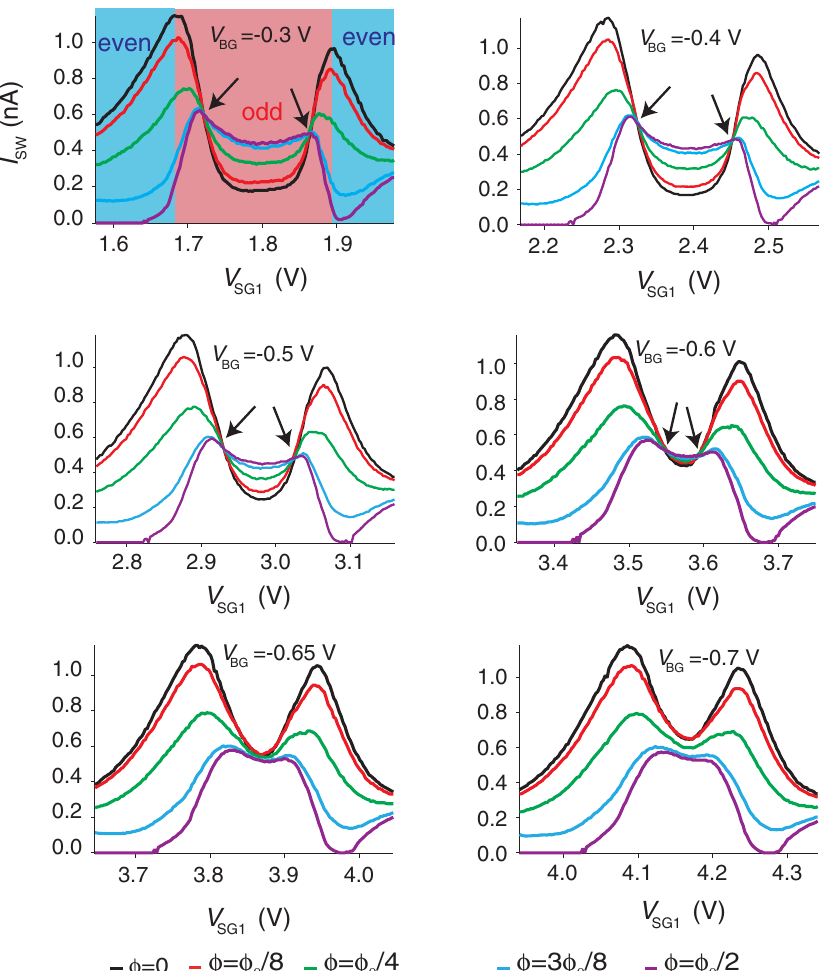
FIG. 5. Switching-current behavior of the nano-SQUID in the Kondo regime. The local gate-voltage V SG1 dependence of the switching current I sw is recorded for five magnetic-field strengths (plotted as different colored lines). The panels follow the decrease of the backgate voltage V BG from (cid:1) 0 : 3 V to (cid:1) 0 : 7 V . [The case V BG ¼ (cid:1) 0 : 5 V is shown in Figs. 4(a)–4(c).] This decrease of the backgate voltage allows us to strengthen the Kondo effect, progressively shrinking the domain associated with (cid:1) -junction behavior. Note that, although V SG2 was corrected for crosstalk in order to stay on the white cut shown in Fig. 2(a), here the actual measured V SG1 is shown. Arrows denote the transition region between 0 and (cid:1) behavior, associated with the crossing point of the switching